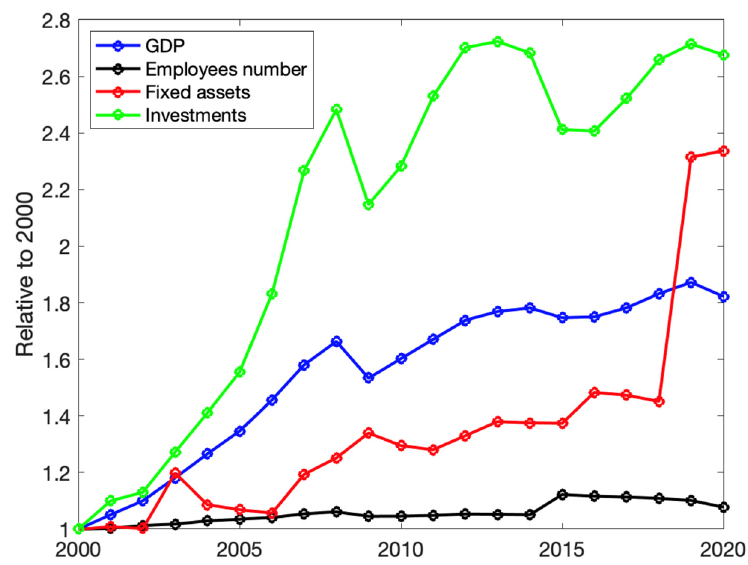
Figure 1. Dynamics of the indicators used for 2000–2020.